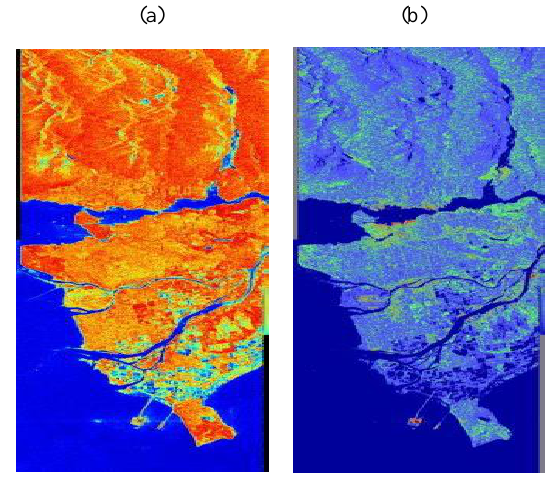
Figure 1. Original quad pol RADARSAT-2 SAR image Using H A Alpha parameters the Pauli RGB image and the H-A alpha classified image get as shown in figure 3 (a) and (b). The H A Alpha classified image shows the sixteen classes out of that the four-major class, viz ., Water, Vegetation, Settlement and Terrain are studied. These results are further used for more detail finding of the geophysical parameters because each class has variation in the scattering